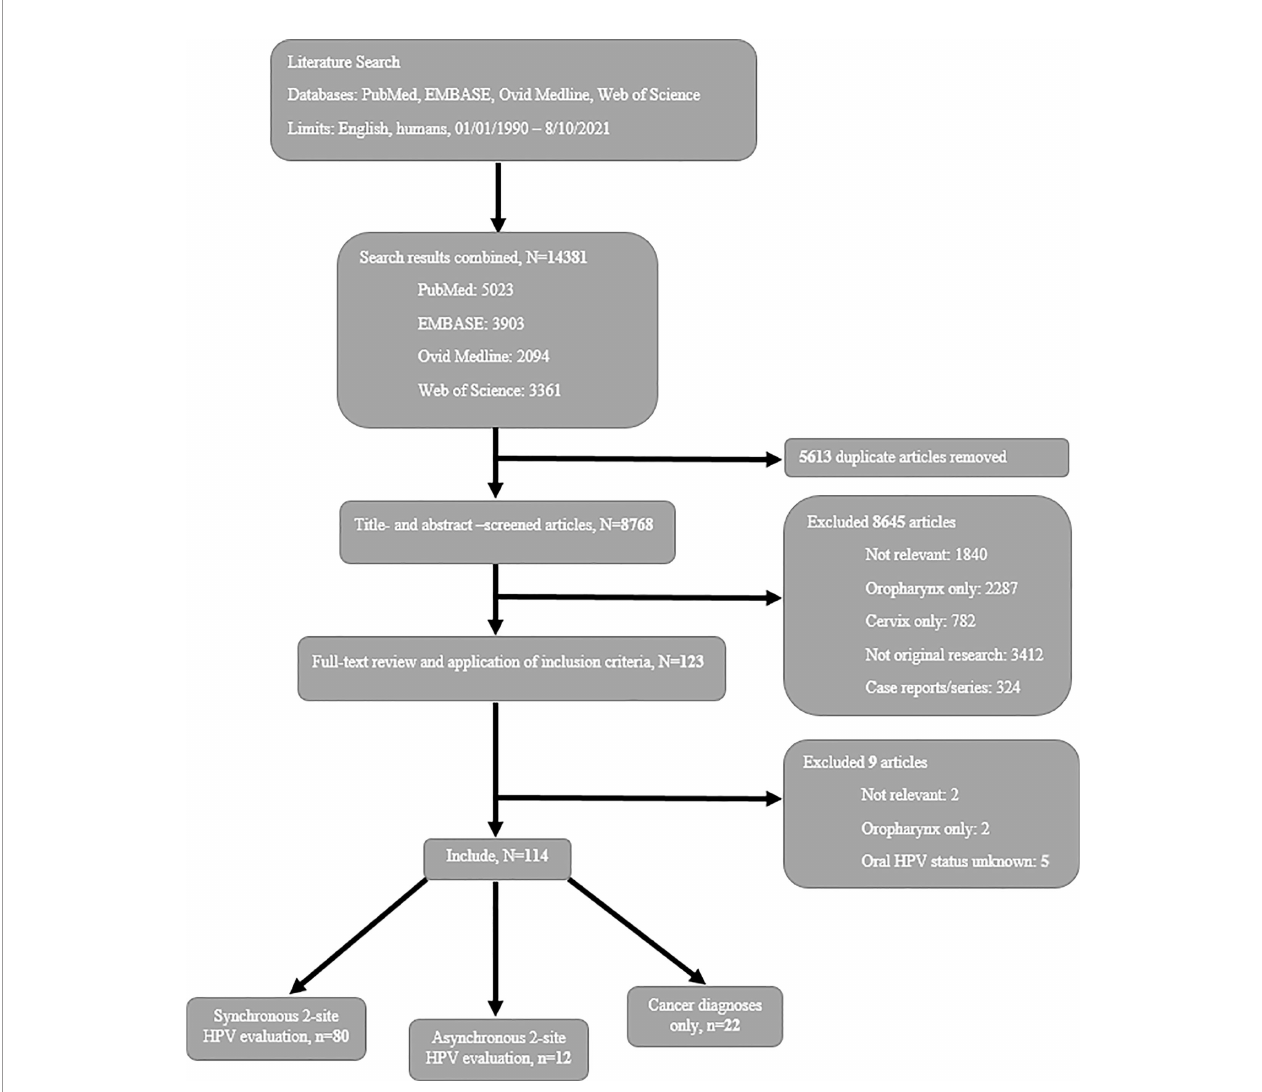
FIGURE 1 | Flow diagram of study selection for a systematic review of oral-cervical HPV infection/cancer epidemiology